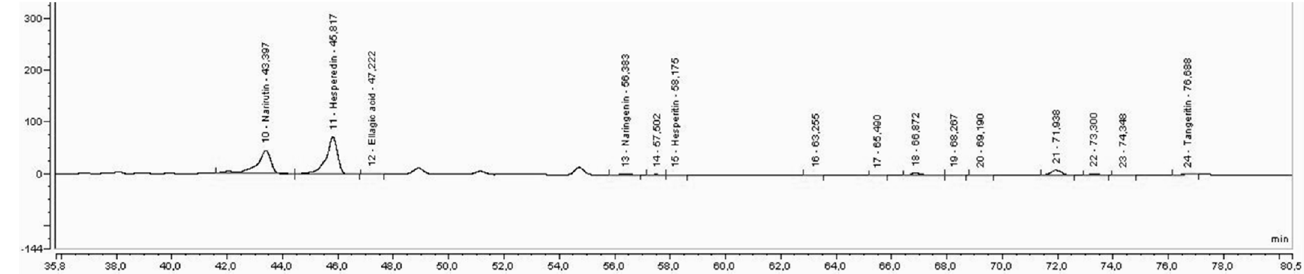
Figure 3. Chromatogram of the extraction performed by solvent.